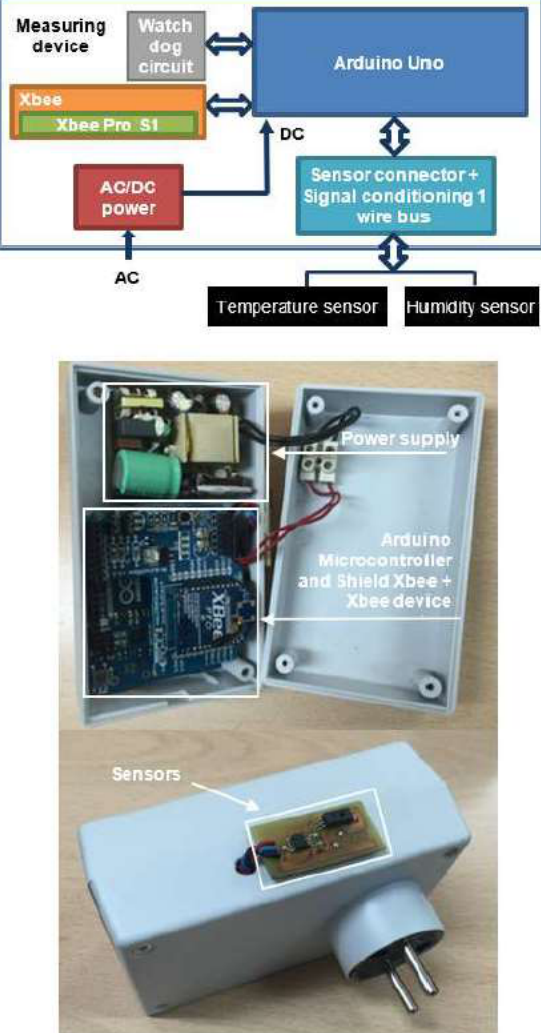
Figure 4. Block diagram and actual appearance of the developed measuring device.